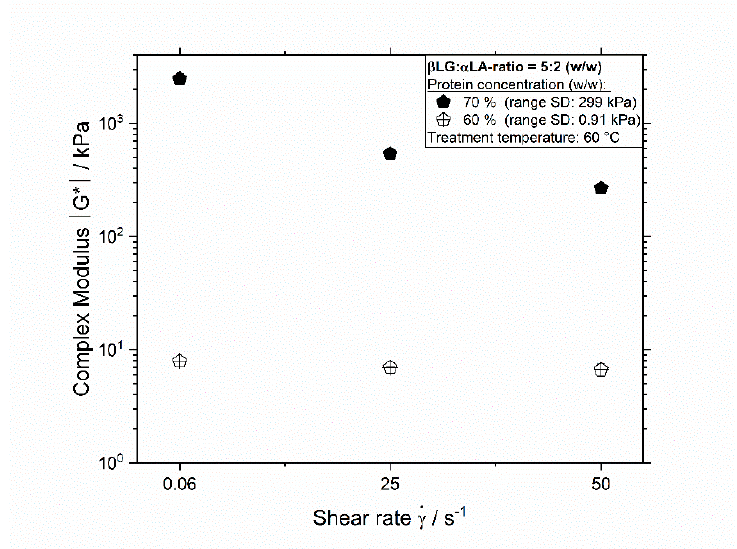
Figure 4. Complex modulus |𝐺 ∗ | of 5:2 systems in dependence of the shear rate for samples treated at 60 °C with a protein concentration of 60% and 70% ( w/w ), bars represent standard deviation (SD).